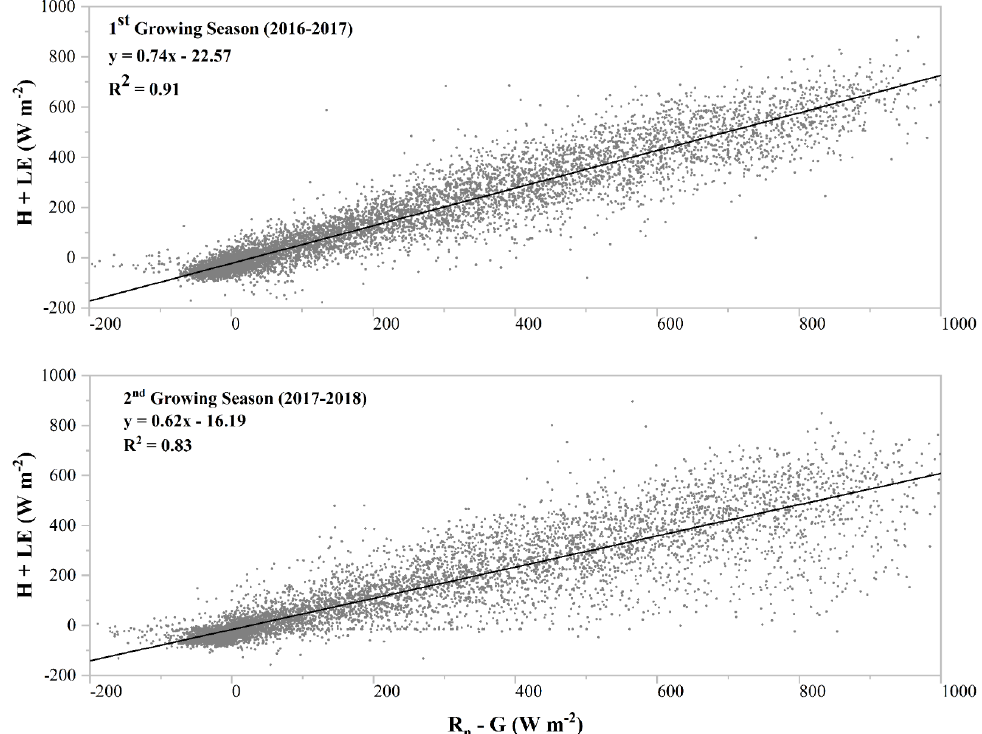
Figure 3. Energy balance closure for the 2016–2017 and 2017–2018 growing seasons of a cool-season grass dominated grassland ecosystem located in Middle Tennessee. Rn, G, H and LE represent net radiation, soil heat flux, sensible heat flux, and latent heat flux; respectively. Data points used were based on 30 min average values. In particular, the first growing season data yielded an R 2 value of 0.91 and an RMSE value of 57 W m − 2 , and the second growing season yielded an R 2 value of 0.83 with an RMSE value of 79 W m − 2 . The slope results from both seasons indicated partial energy balance closure (<1), indicating that measured turbulence fluxes accounted for 74% and 62% of available energy loss during each growing season, respectively. The rest of the available energy was primarily transferred to the above-heat-flux-sensor soil layer, veg- etation canopy (mainly used for photosynthesis), and the atmospheric air layer between the soil horizon and the IRGA. Foot-print analysis [23] indicated that at least 70–80% of flux data was from within the research field throughout the entire growing season. The overall patterns of daily cumulative NEE, GPP, and ER for the entire pasture ecosystem are depicted in Figure 4.